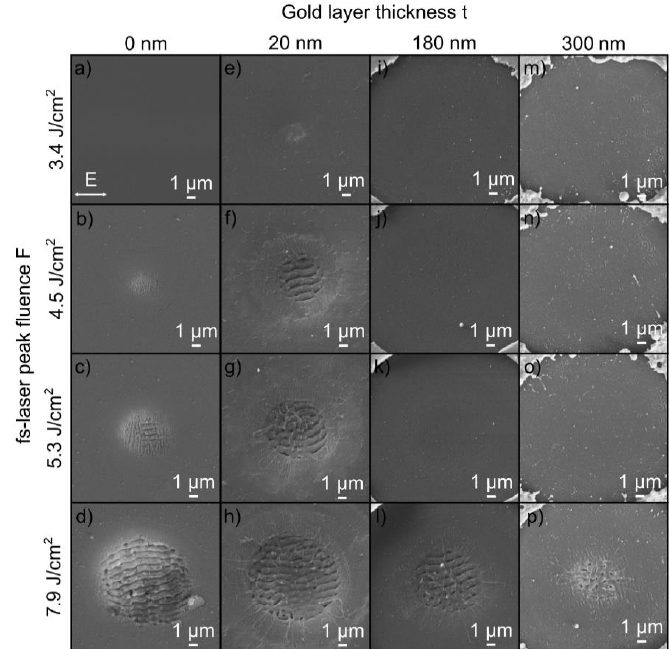
Figure 2. SEM micrographs of the fused silica surface upon the irradiation with N = 5 fs-laser pulses as a function of fs-laser peak fluence F and gold layer thickness t : ( a – d ) uncoated fused silica surface, ( e – h ) t = 20 nm, ( i – l ) t = 180 nm and ( m – p ) t = 300 nm. The direction of the linear beam polarization ( E -field vector) is illustrated in ( a ).